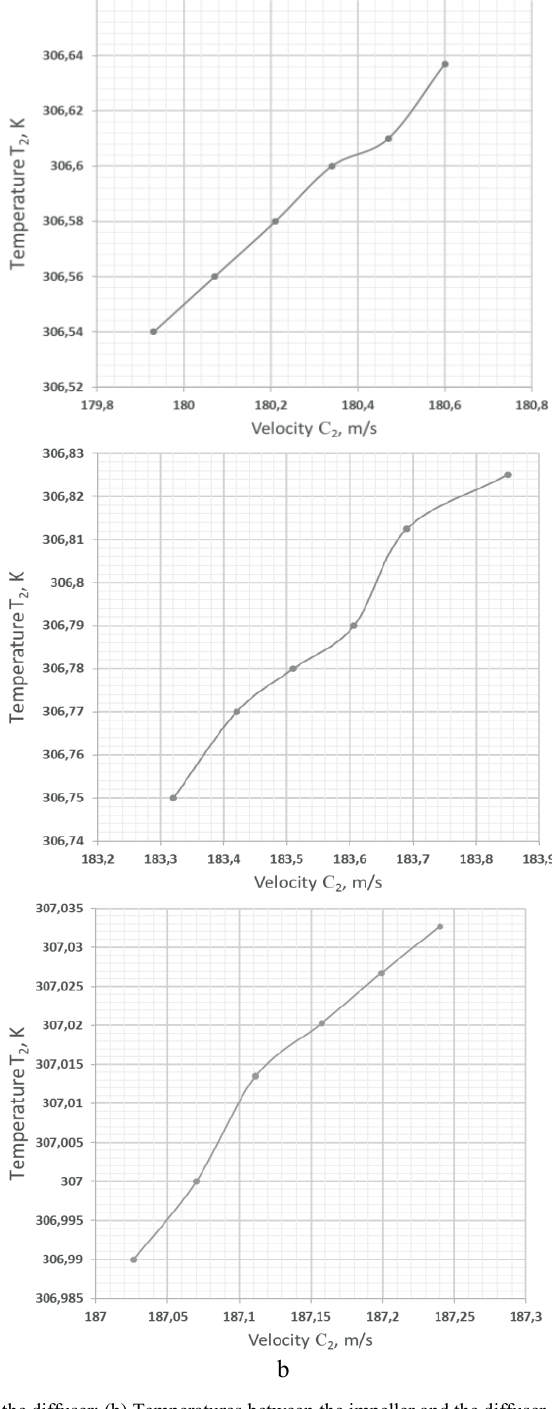
Fig. 5. Velocity C 2 dependences on: (a) Densities between the impeller and the diffuser; (b) Temperatures between the impeller and the